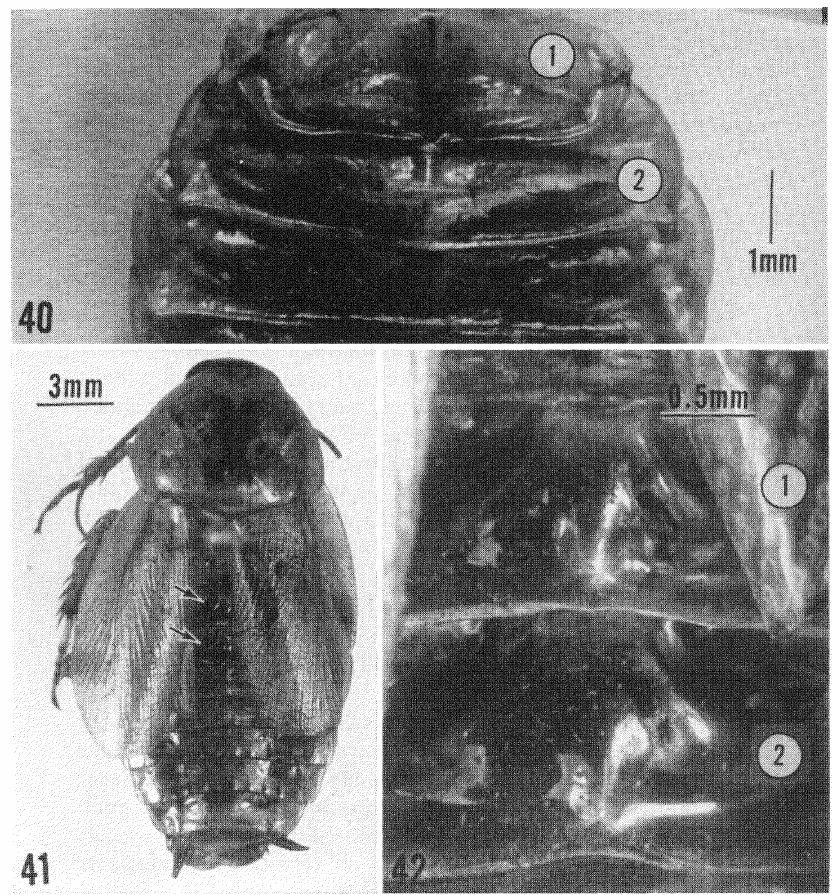
Figs. 40-42. Poeciloderrhis spp. 40. (72, MCZ). Poeciloderrhis sp. .d. Tergal modifications on segments and 2 (circled numbers). Annapolis, Goias, Brazil (det. Roth). (genitalia in Figs. 28-30). 41-42. (183, USNM). P. catharlna. The tergal glands are indicated, by arrows (Fig. 41) and circled numerals (Fig. 42). (Type of dudreia catharina Shelford, St. Catharina, Brazil; genitalia in Figs.